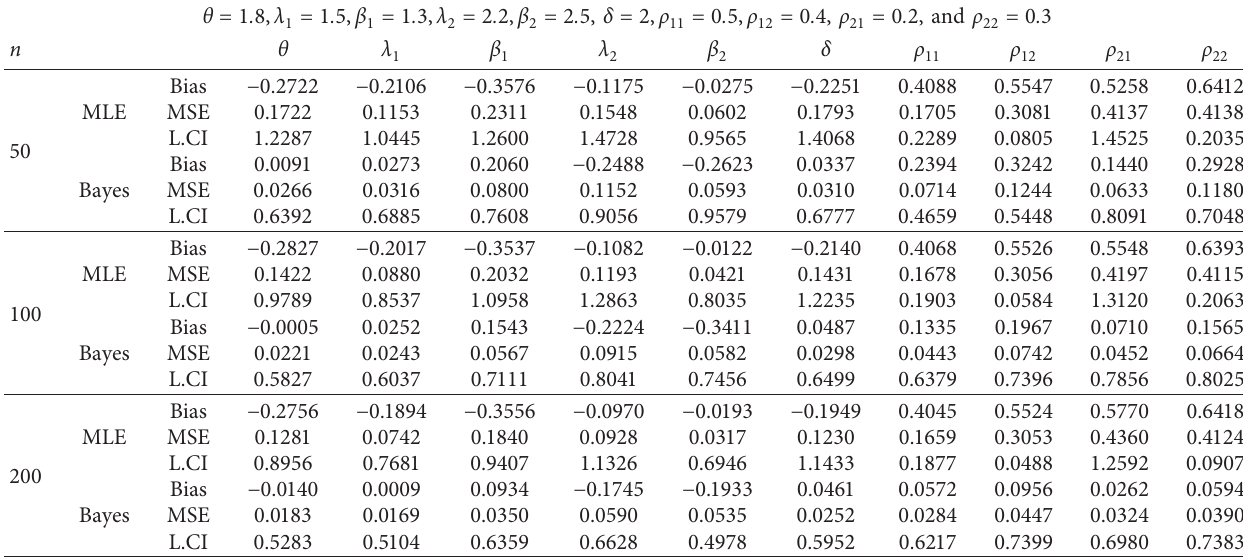
Table 6: MLE and Bayesian estimation with different sample sizes in dependent case (Case